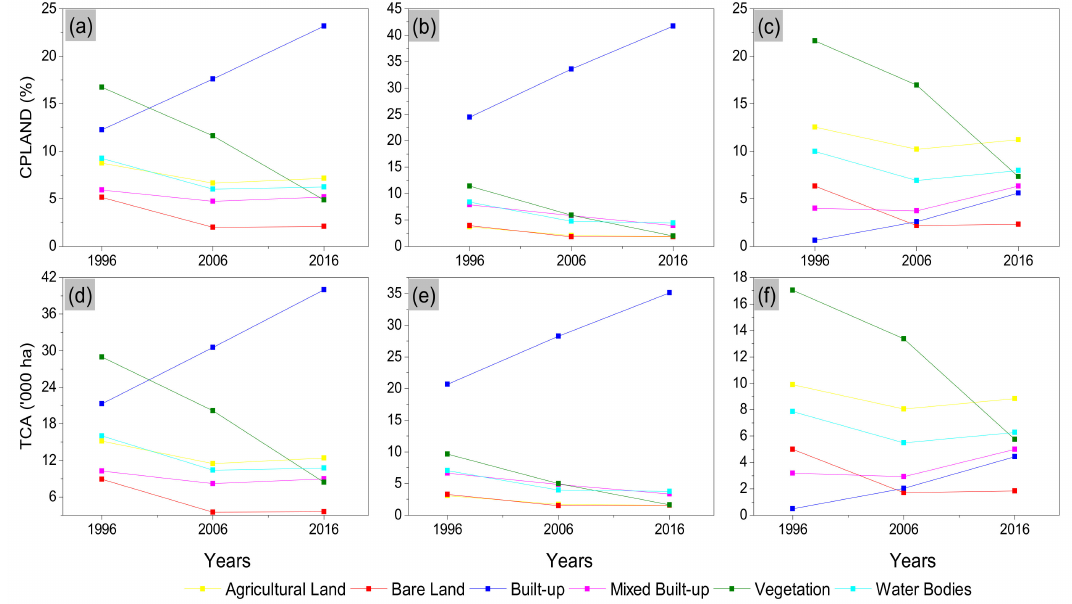
Figure 12. Class level CPLAND and TCA; ( a – c ) present results of CPLAND metric for KMA, KMA-urban, and KMA-rural, respectively, in 1996, 2006, and 2016; while ( d – f ) represent CAI_MN for KMA, KMA-urban, and KMA-rural, respectively, in 1996, 2006, and 2016.